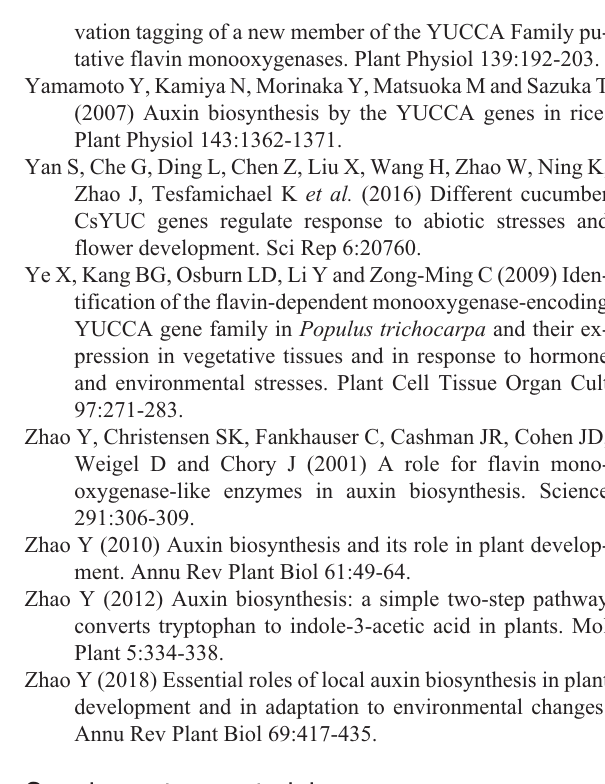
Figure S1 - IAA levels in roots and shoots of different lines and their crosses with 35S::YUC4. Figure S2 - Root architecture of 35S::YUC4. Figure S3 - Quantification of relative GUS expression of DR5::GUS in WT and 35S::YUC4 backgrounds. Figure S4 - Auxin responsive gene expression is exacer- bated in shoots and roots of 35S::YUC4 seedlings upon NPA treatment. Figure S5 - Auxin-inducible BA3::GUS expression in re- sponse to NPA